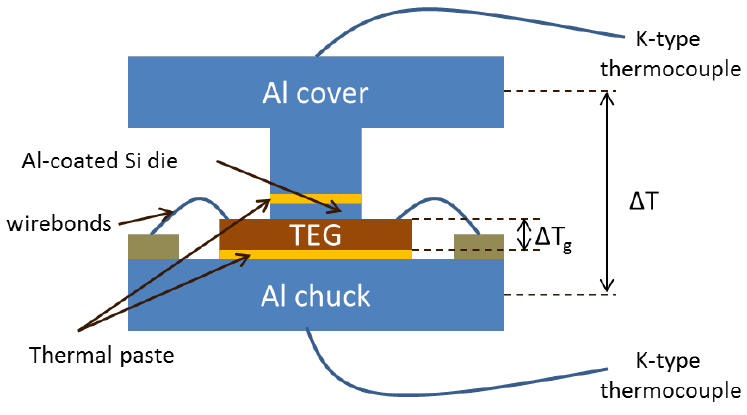
Figure 2. Schematic representation of the TEG in its